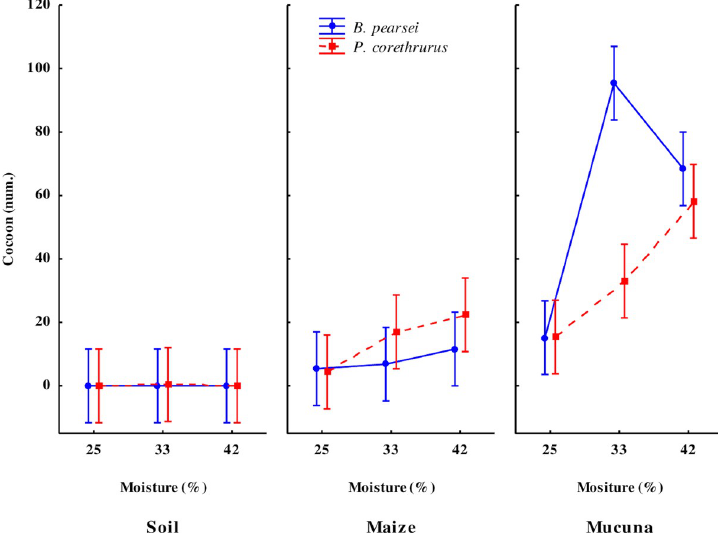
Fig 3. Number of cocoons produced by the tropical endogeic earthworms Pontoscolex corethrurus (invasive) and Balanteodrilus pearsei (native) at 100 days of culture under the interaction of three diets of different nutritional quality and three moisture content levels in soil with low anthropic impact. Vertical lines represent standard error.